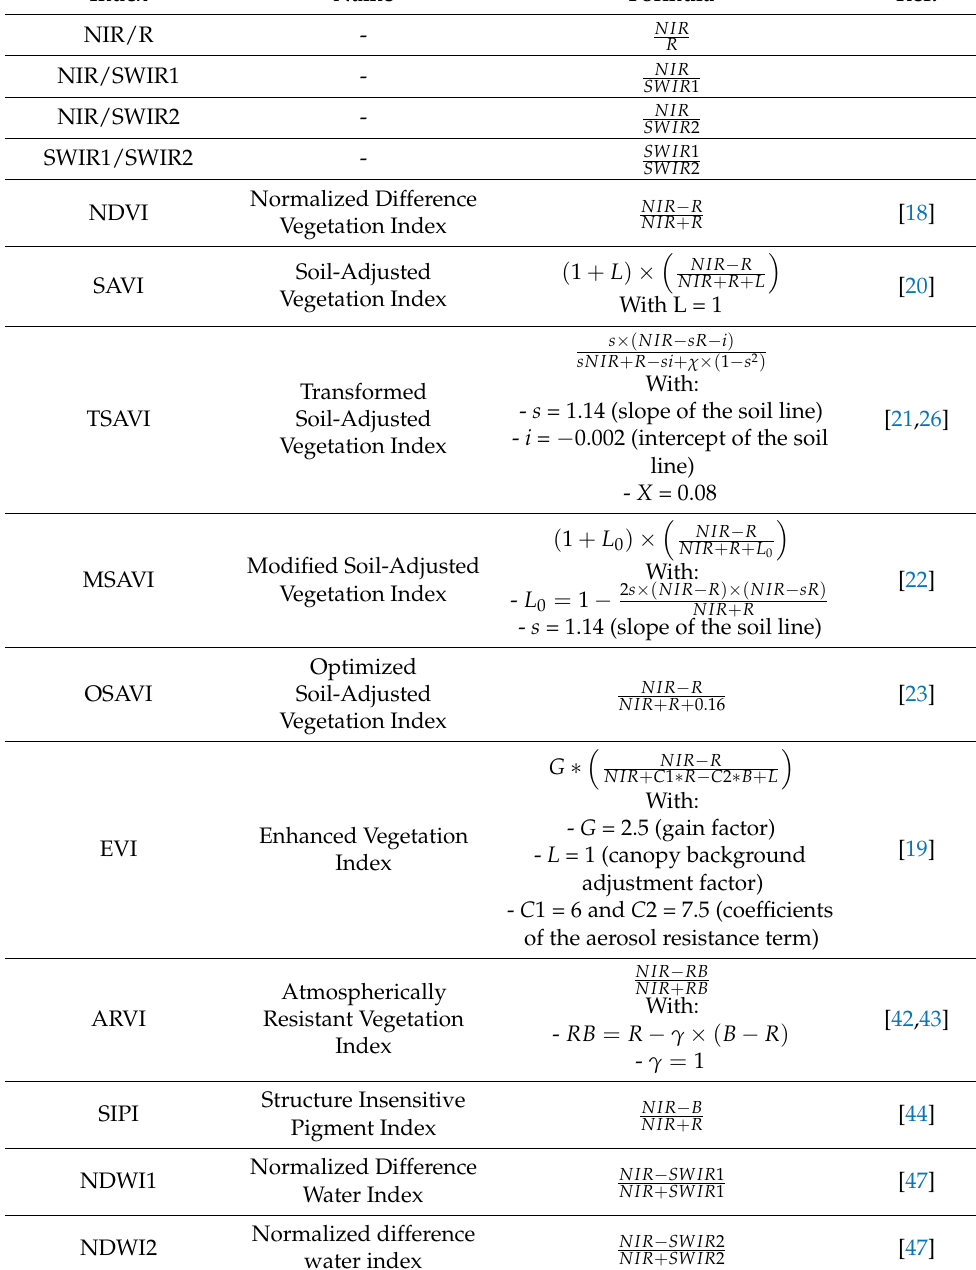
Table 1. Landsat 7 ETM+-derived spectral